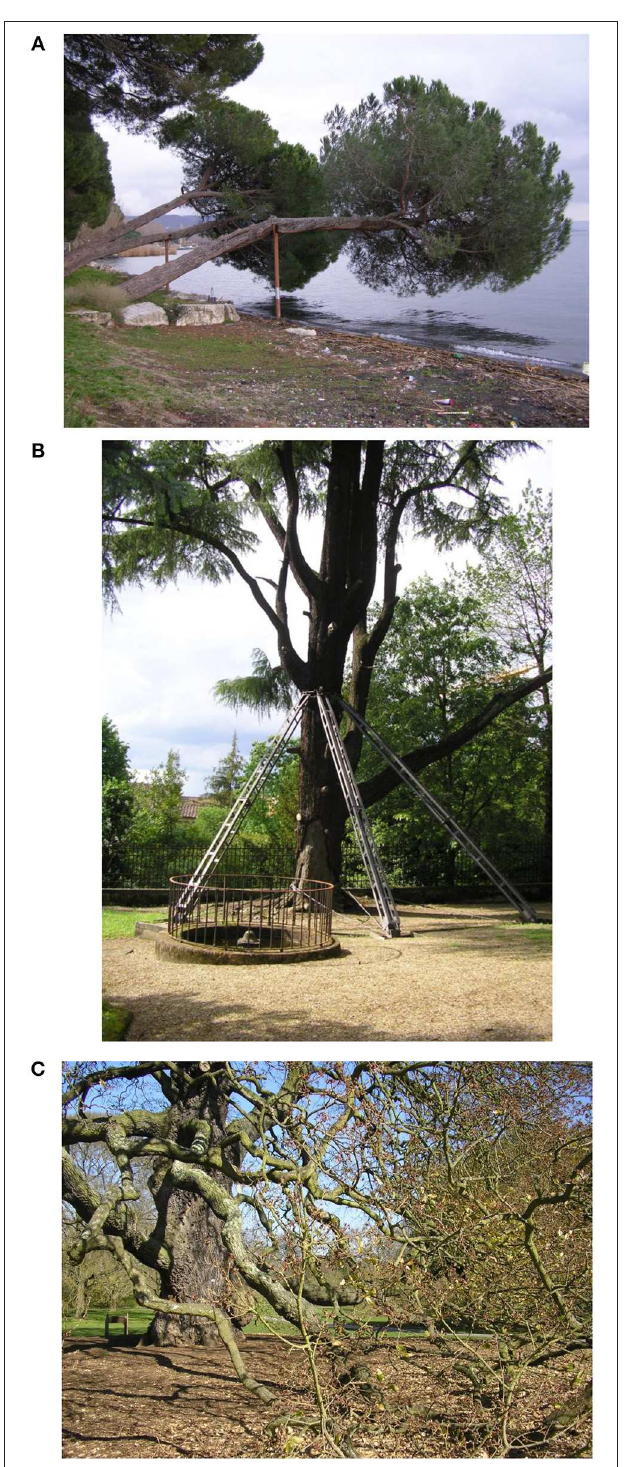
FIGURE 2 | Examples of old trees characterizing with their presence particular places and becoming part of the place identity. (A) An extreme case of place-tree identification. In the town of Bolsena, central Italy, pine trees ( Pinus pinea L.) are maintained in spite of their precarious equilibrium as “witness” of the anthropic landscape designed along the lakeshore. (B) In the historic